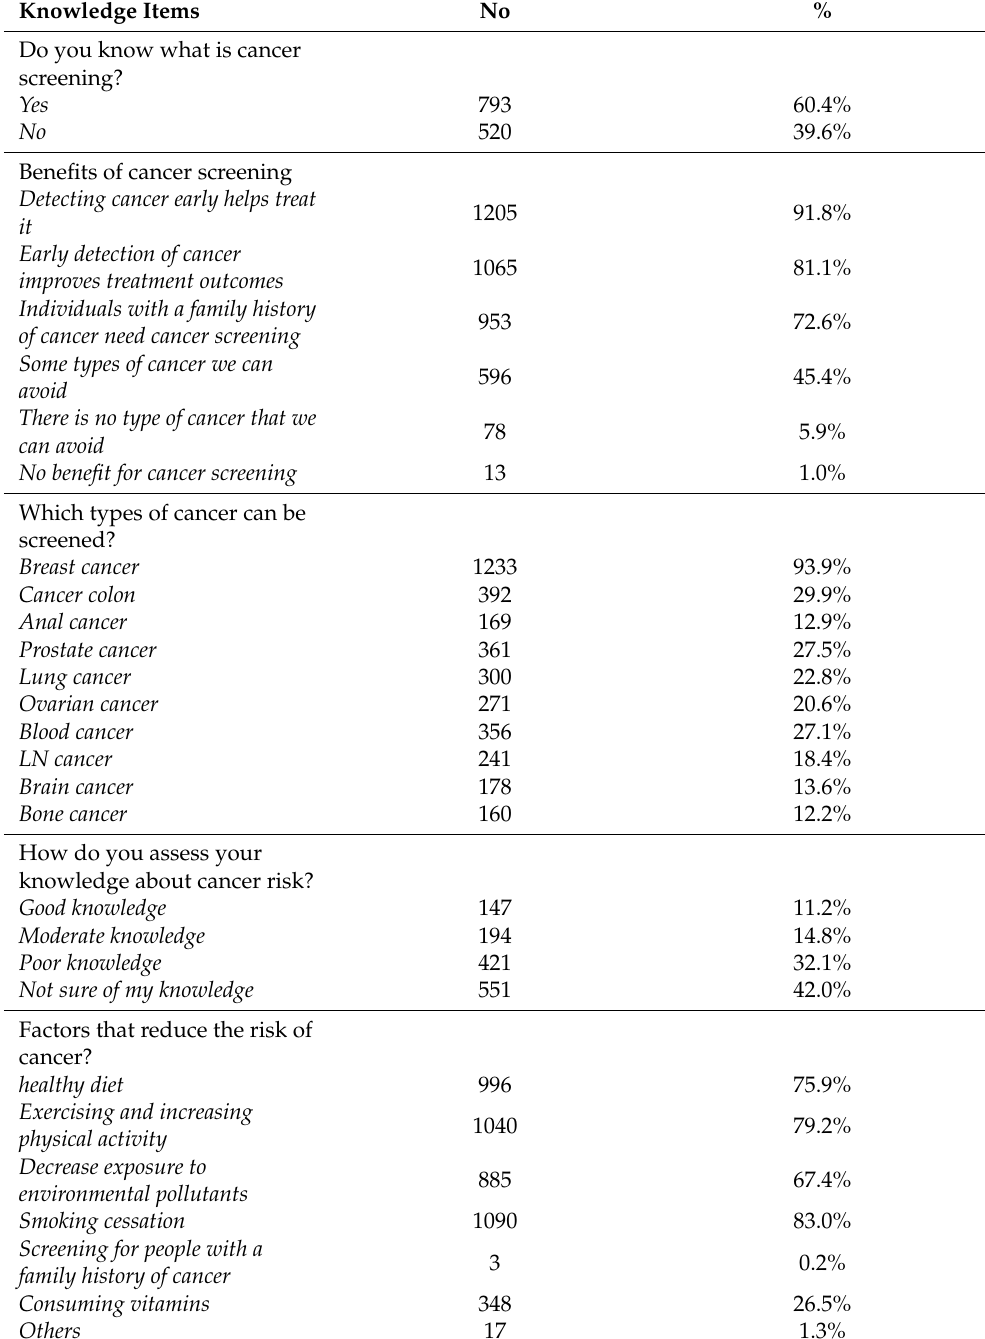
Table 2. Public knowledge regarding cancer and cancer screening, in Saudi